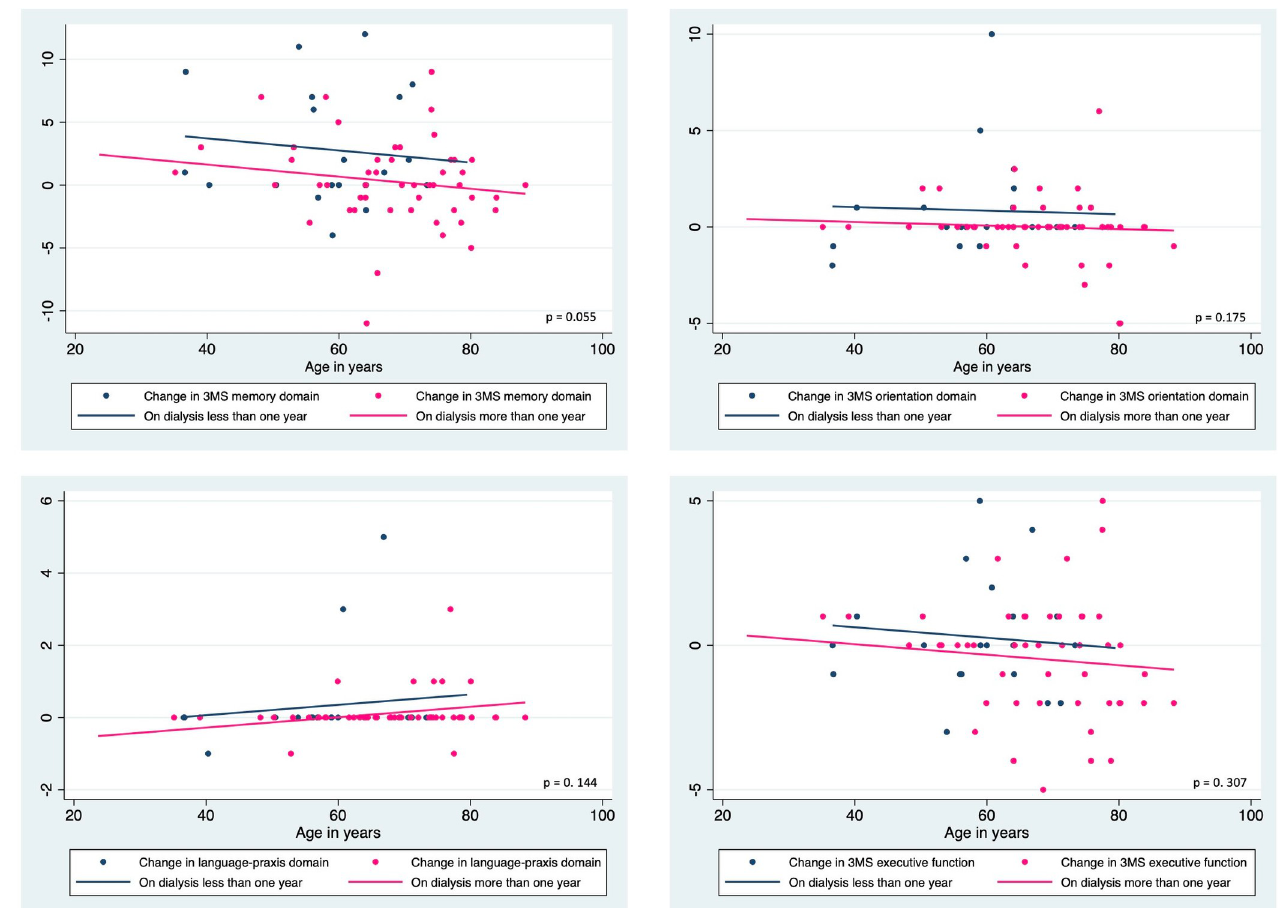
Fig 5. Change scores of memory, orientation, praxis and executive function domains of cognitive function in ESKD patients with dialysis vintage < 1-year and > 1-year with fitted regression lines from ANCOVA models using age as a continuous covariate.